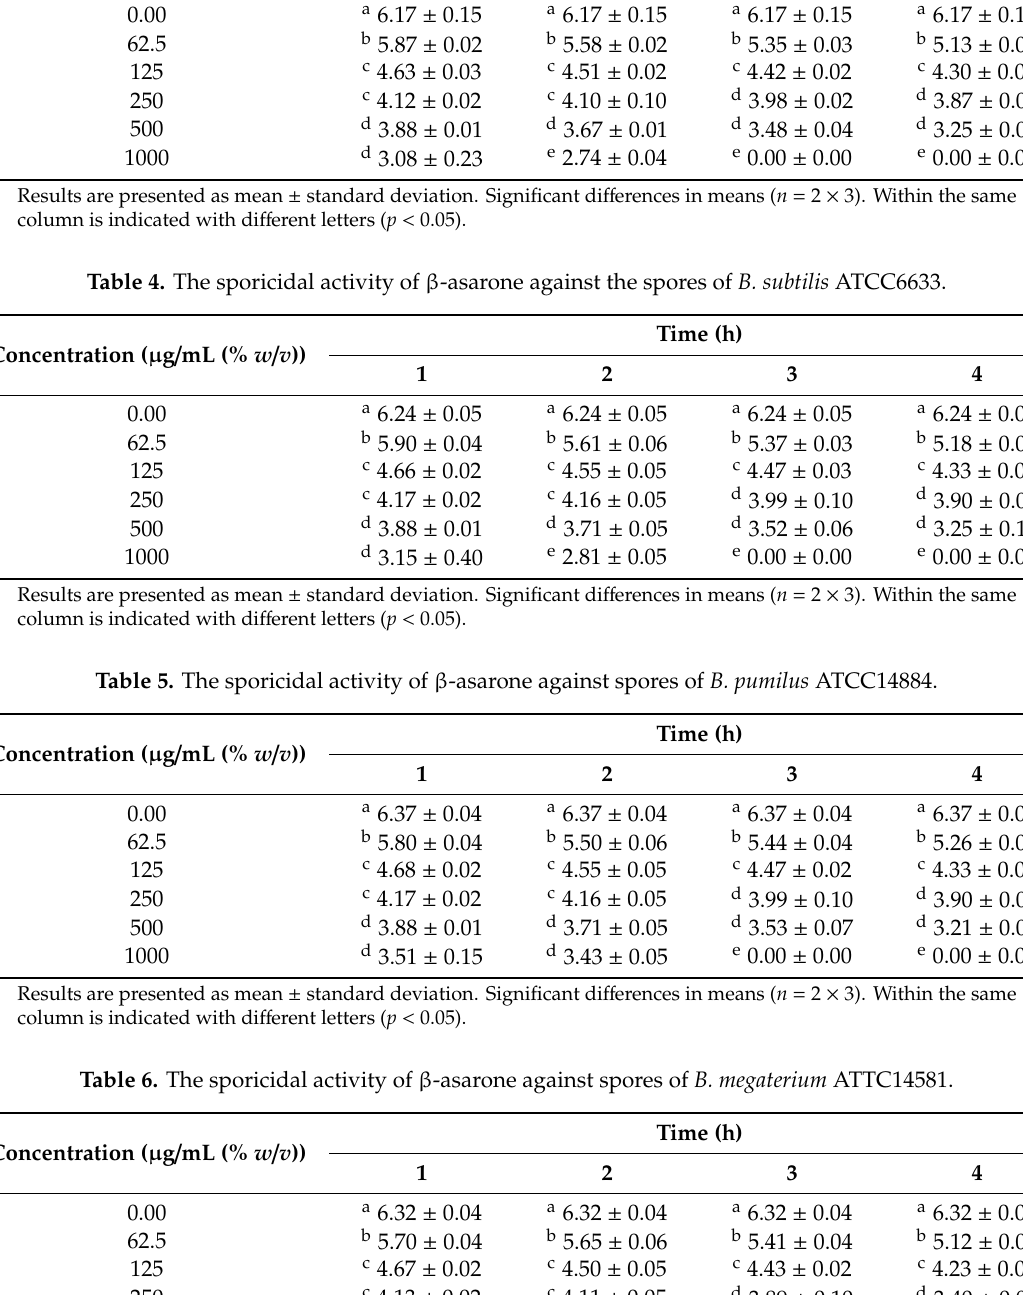
Table 3. The sporicidal activity of β -asarone against the spores of B. cereus ATCC33019. Concentration ( µ g / mL (% w / v ))